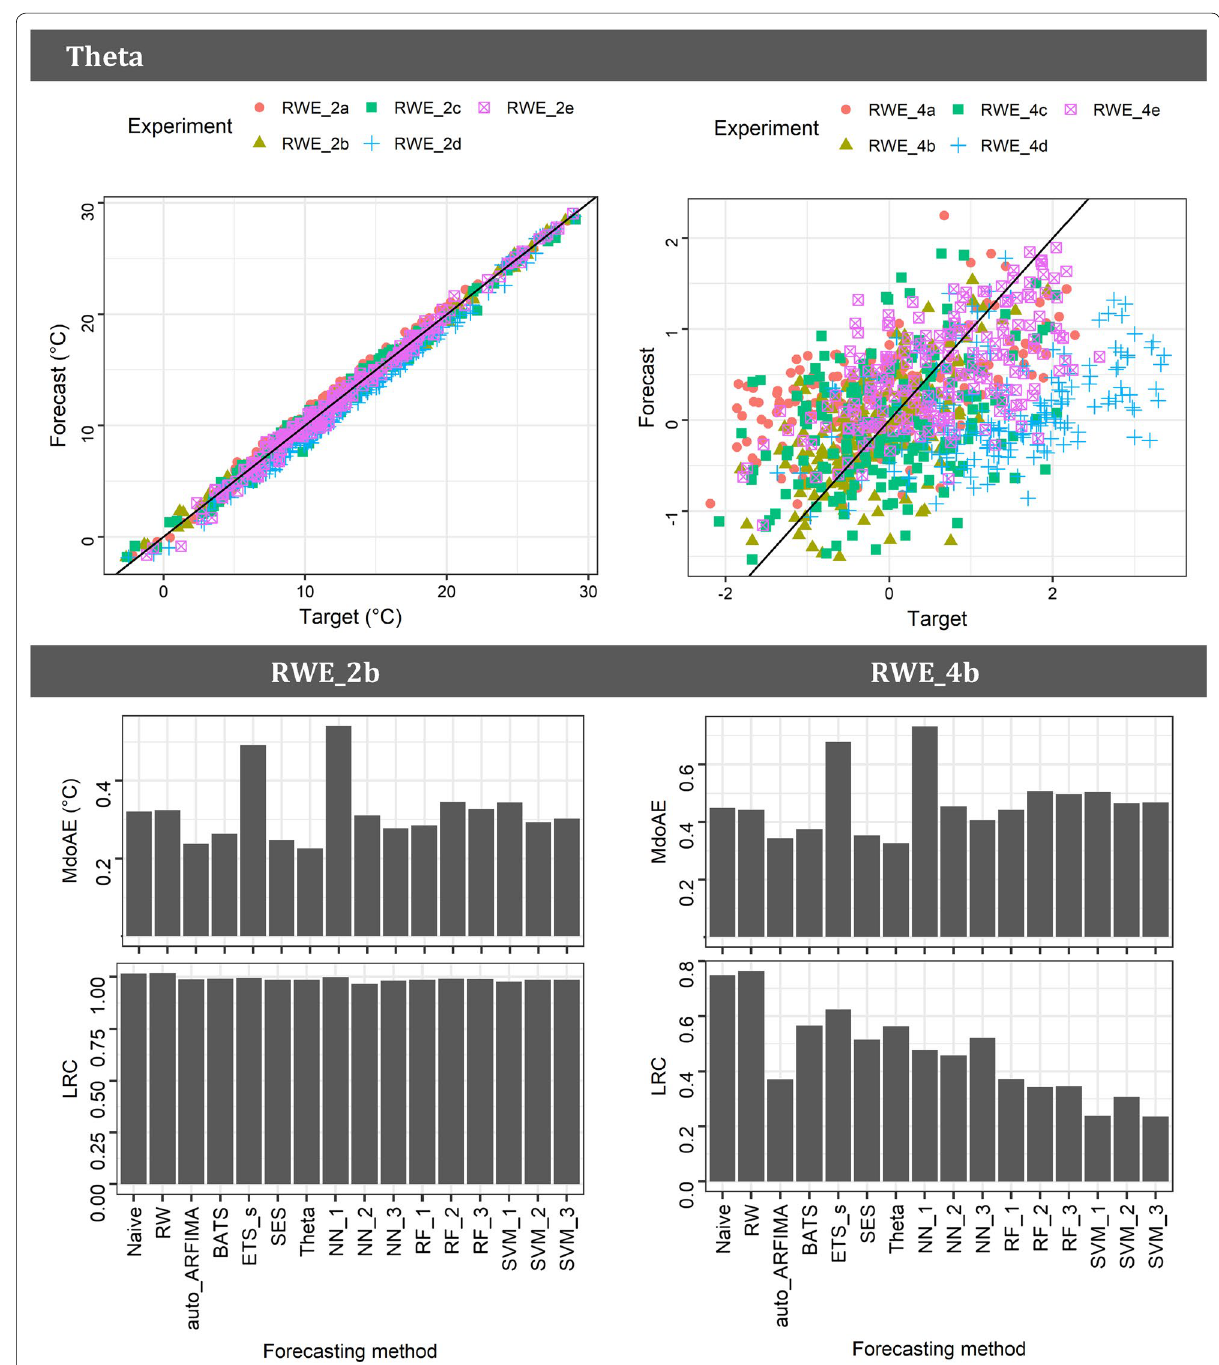
Fig. 5 Comparison in brief between the experiments using the TempDat and StandTempDat